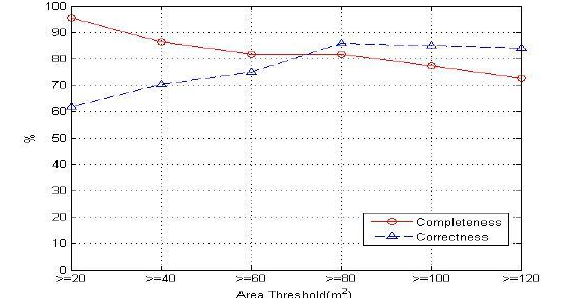
Figure 8. The influence of area threshold on building